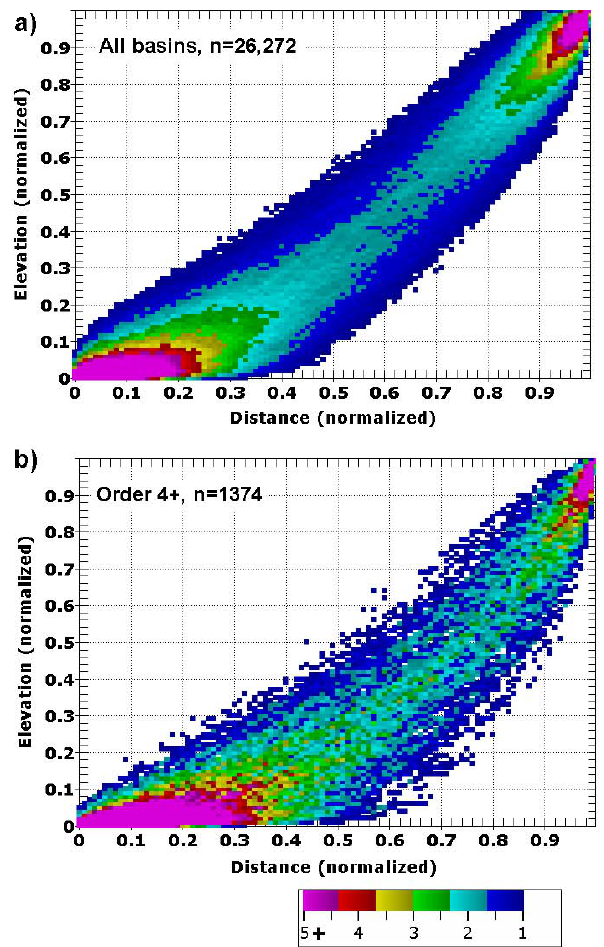
Fig. 6. Density of normalized longitudinal thalweg profiles for all basins (a) and those of Strahler order 4 and larger (b) . The density records the percentage of thalwegs in percentile bins both horizon- tally and vertically. Colors range from 1% (blue) to 5% or greater (violet). Note the displacement downward and to the right for the larger